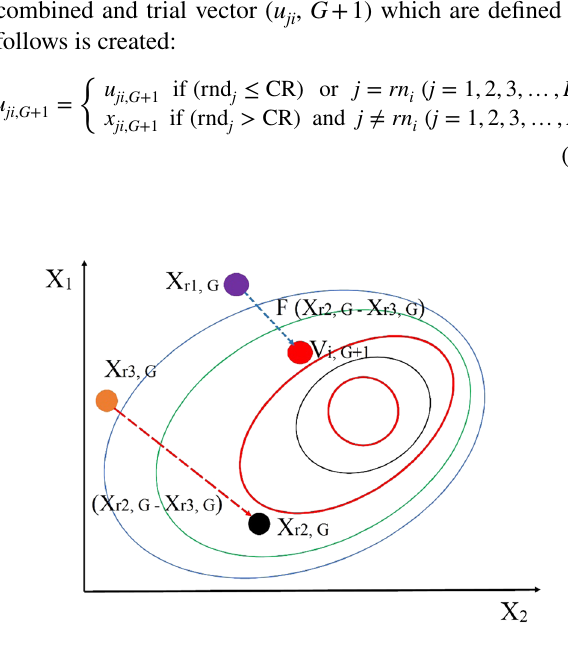
Fig. 3 Mutation operation in